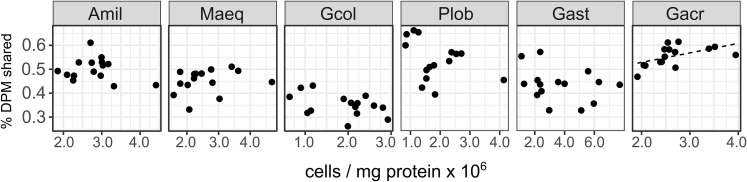
Host-symbiont cooperation in ambient conditions as a function of Symbiodinium cell density across species.The proportion of photosynthetically fixed carbon translocated to the host in ambient conditions (27 °C) as a function of Symbiodinium cell density by species (Amil: Acropora millepora, Maeq: Montipora aequituberculata, Gcol: Goniopora columna, Plob: Porites lobata, Gast: Galaxea astreata, Gacr: Galaxea acrhelia).